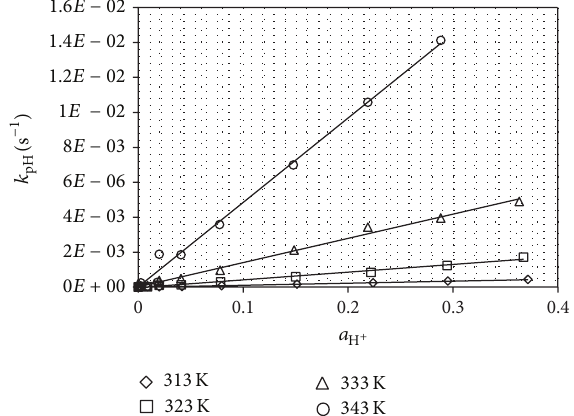
= 𝑓(𝑎 ) for the degradation of PPD in aqueous pH H +